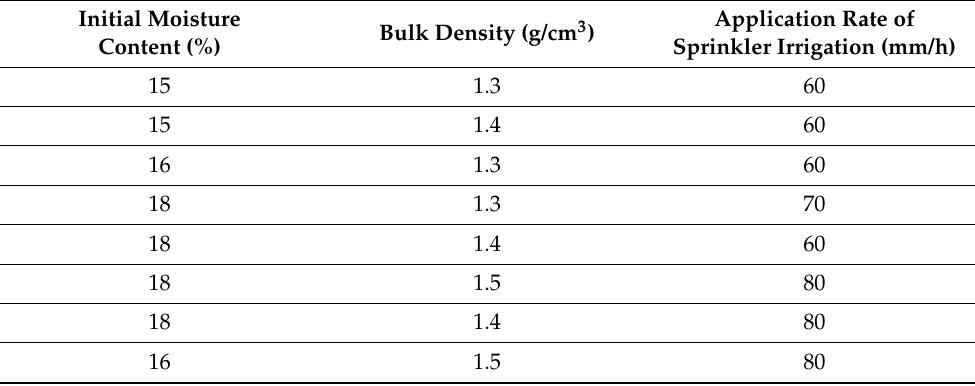
Table 5. Experimental variable